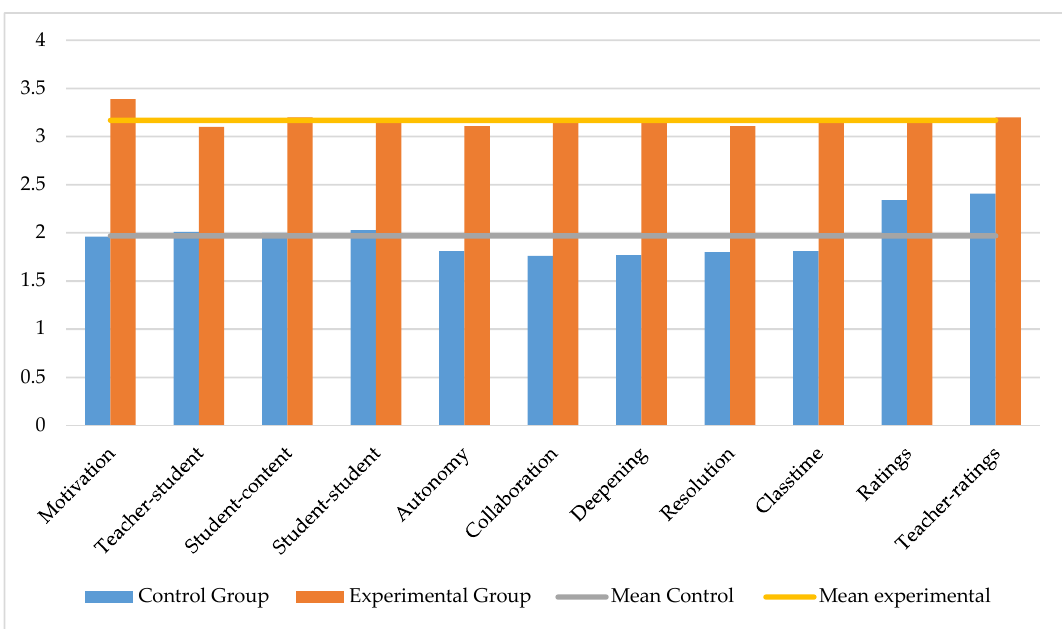
Figure 1. Comparison between control group and experimental group.